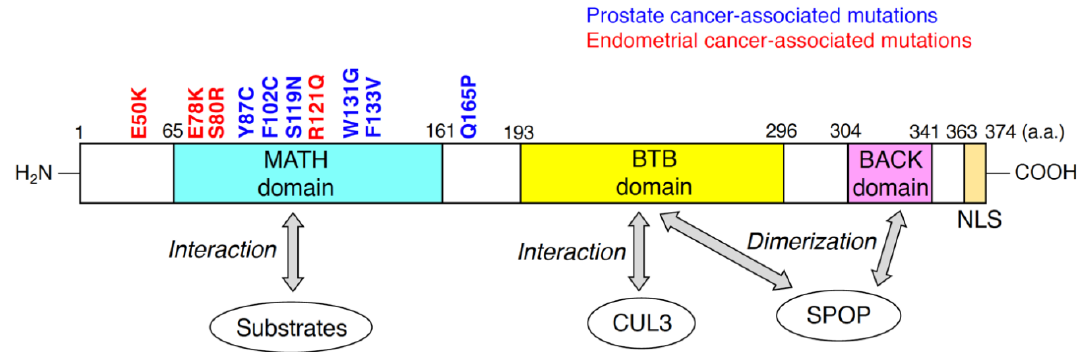
Figure 1. Domain structure of human speckle-type Bric-à-brac/Tramtrack/Broad complex (BTB)/POZ protein (SPOP) predicted by the Pfam database (https://pfam.xfam.org). Substrates of the cullin-3 (CUL3)/SPOP E3 complex directly bind to meprin and TRAF-C homology (MATH) domain of SPOP. The BTB domain of SPOP is responsible for the interaction with CUL3 and SPOP dimerization. BTB and C-terminal Kelch (BACK) domain is also required for SPOP dimerization. Representative missense mutations detected in prostate cancers and endometrial cancers are indicated in blue and red, respectively. The numbers in the domain structure represent the order of amino acids. The nuclear localization sequence (NLS) is also shown.